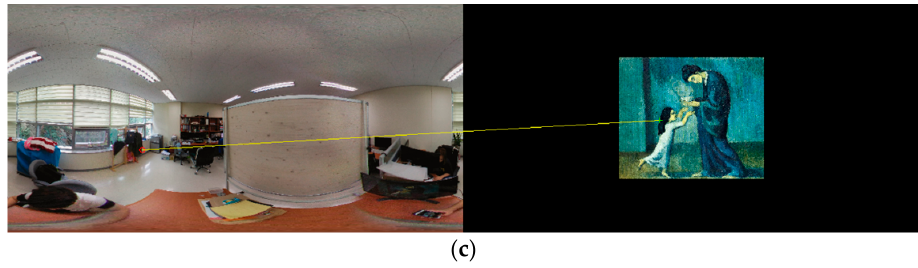
Figure 13. Matched results for the 32-inch monitor for three types of distortions. ( a ) Matched results for low distortion; ( b ) Matched results for middle distortion; ( c ) Matched results for high distortion.